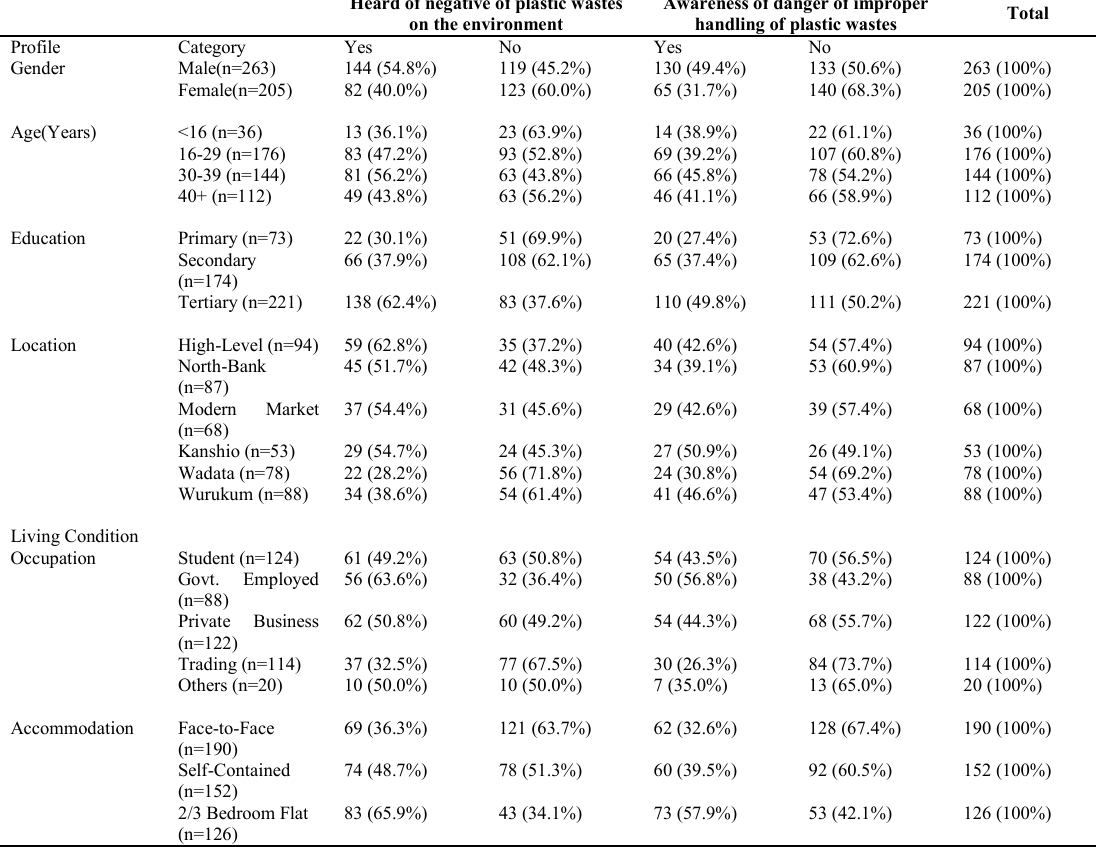
Table 7: Awareness of negative environmental impact and danger of improper disposal of plastic wastes Heard of negative of plastic wastes on the environment